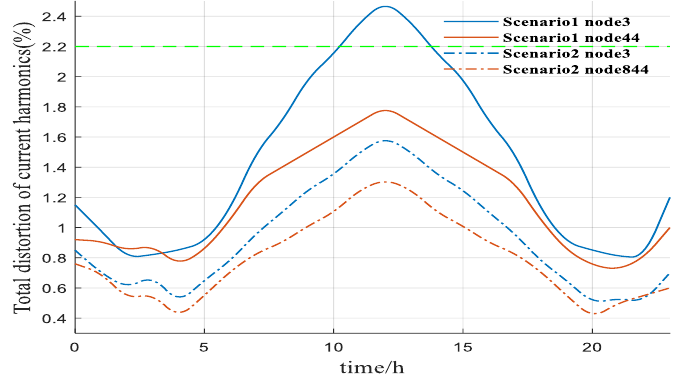
Figure 10. Current harmonic distortion rate curve.